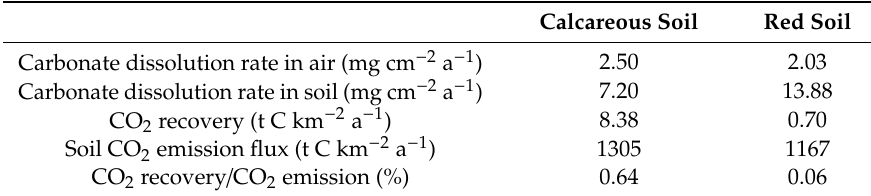
Table 2. The ratio of CO 2 recovery to CO 2 emission in calcareous soil and red